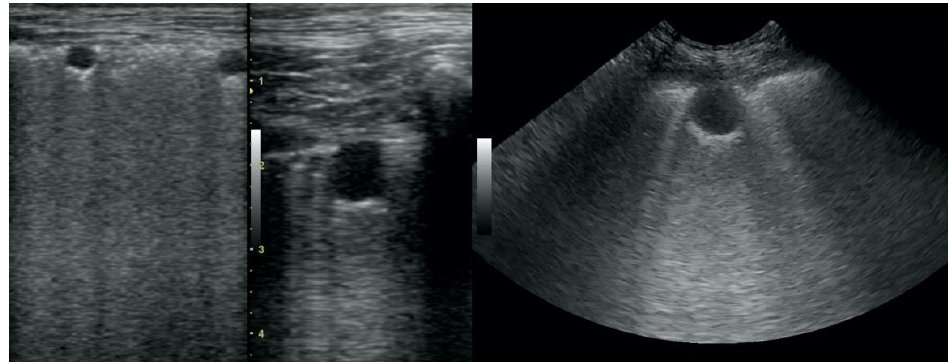
Figure 7. Hepatization with aeration in the course of pneumonia ( A – C ) and lung cancer ( D ).